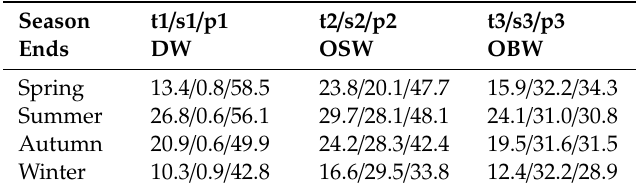
Table 1. Example of the temperature (t, ◦ C), salinity (s), and POC (p, µ mol L − 1 ) for the end-members of DW, OSW, and OBW in the ES-TGP used in the three end-member mixing